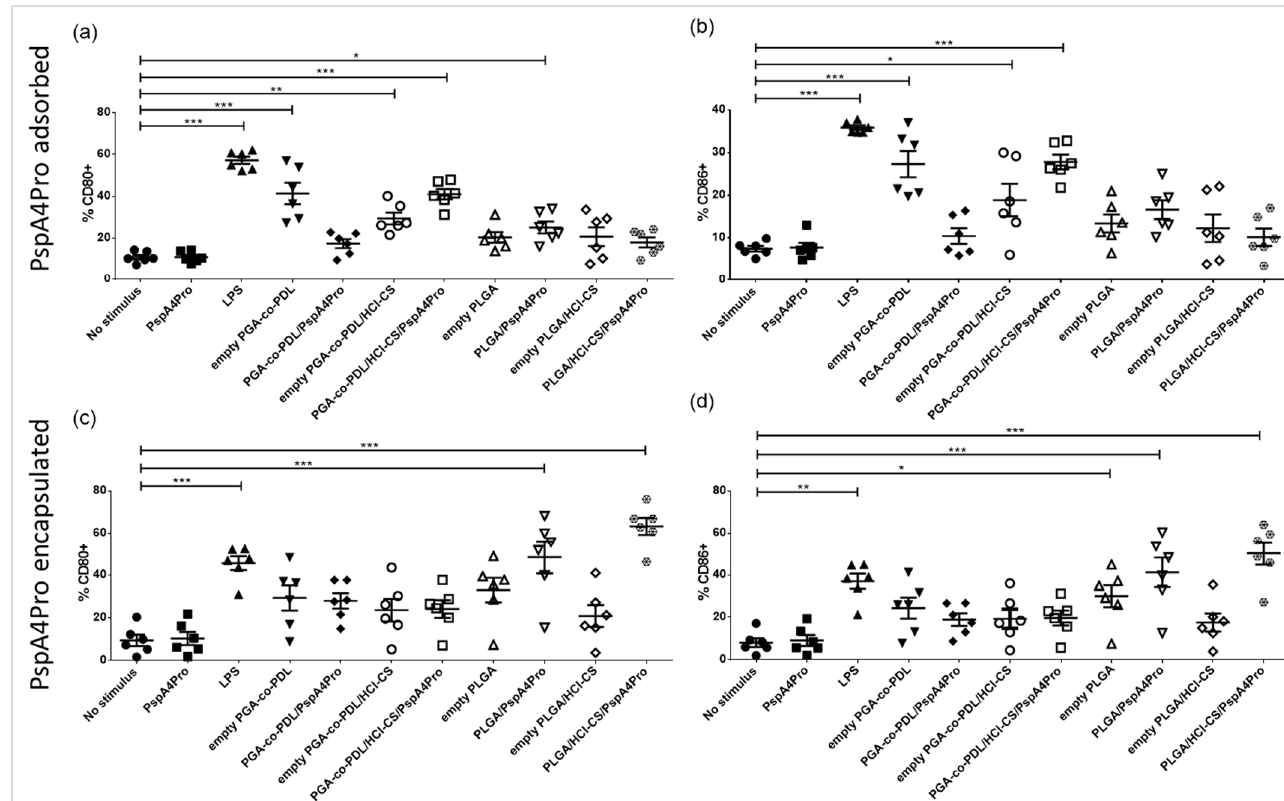
Figure 7. Activation of dendritic cells by NCMPs carrying different NP formulations containing adsorbed or encapsulated PspA4Pro. NPs were prepared with or without chitosan hydrochloride (HCl-CS) and contain PspA4Pro adsorbed onto the surface ( a , b ) or encapsulated into the NPs ( c , d ). Percentage of CD80+ DCs ( a , c ); percentage of CD86+ DCs ( b , d ). Significant differences in relation to the control group without stimulus are indicated (one-way ANOVA, Tukey’s comparison test). * p < 0.05, ** p < 0.01, *** p < 0.001.